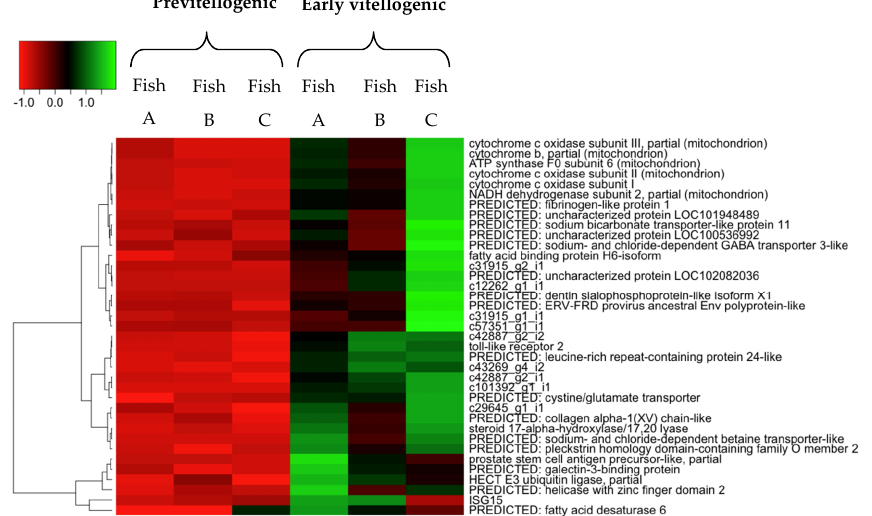
Figure 3. Heat-map of differentially expressed genes in the ovary of hāpuku (Polyprion oxygeneios) during previtellogenic (n = 3 fish) and early vitellogenic (n = 3 fish) stages of oogenesis. Expression levels were measured in reads per kilobase of transcript per million mapped reads (RPKM) from normalised values (red = lower expression and green = higher expression as oogenesis progresses from previtellogenic to early vitellogenic stages of development).